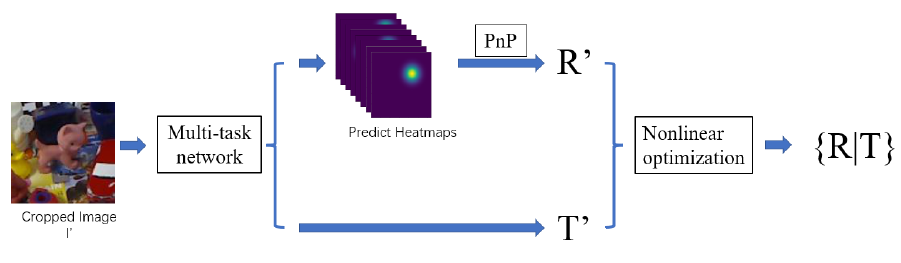
Figure 3. Visualization of proposed pipeline. We use a multi-task network to simultaneously predict the heatmap and translation, and use a nonlinear optimization method to calculate the pose.